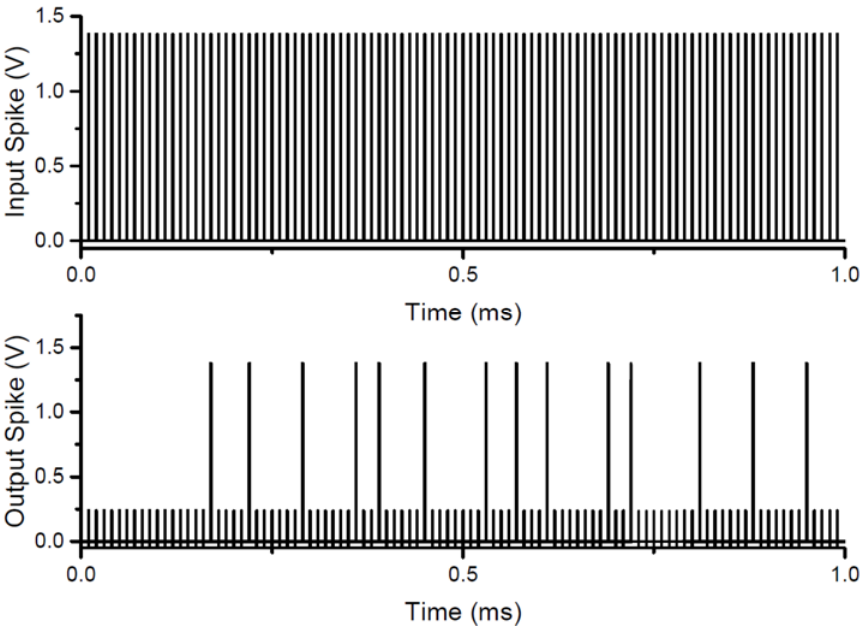
Figure 31. Input and output spikes of an integrate ‐ and ‐ fire (IF) neuron with memresitor synapses.